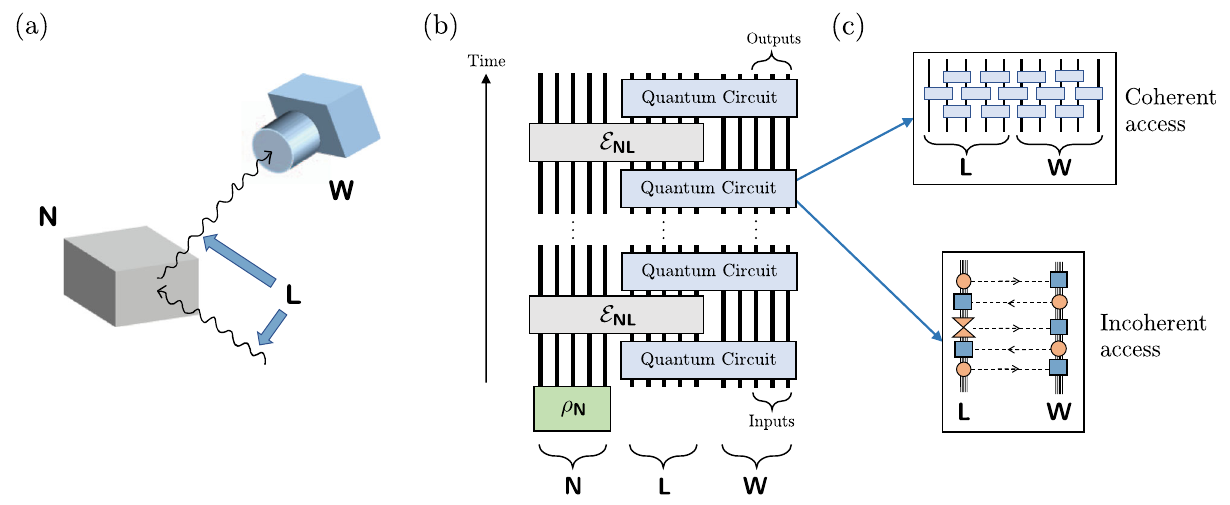
Fig. 1 Schematic of a quantum algorithmic measurement. a Illustration of a QUALM for X-ray diffraction, where N is the crystal sample, L consists of the X-ray photons (including the incoming and outgoing ones), and W contains the camera and other lab equipment for taking and processing the image. b Schematic illustrating the structure of a QUALM as an interaction between Nature and the experimentalist ’ s controlled degrees of freedom. Here N represents the ‘ Nature ’ register, L is the ‘ lab ’ register, and W is the ‘ working space ’ register. The experimentalist does not have direct measurement access to the N register, which should be thought of as the “ hidden ” degrees of freedom of the physical system on which the experiment is conducted. The initial state on N is ρ N , and the input and output subsets of W are speci fi ed. c Illustration of the coherent and incoherent access QUALMs. Coherent access QUALMs allow for general unitary dynamics on the lab and working spaces. Incoherent access QUALMs only permit classical communication between the lab and working spaces; each orange solid circle is a completely positive (CP) map and each blue box is a completely positive trace-preserving (CPTP) map. At least one of the CP maps between each application of the lab oracle is a complete measurement, indicated by a double triangle. The direction of the arrows in the horizontal dashed lines indicates the direction of classical information fl